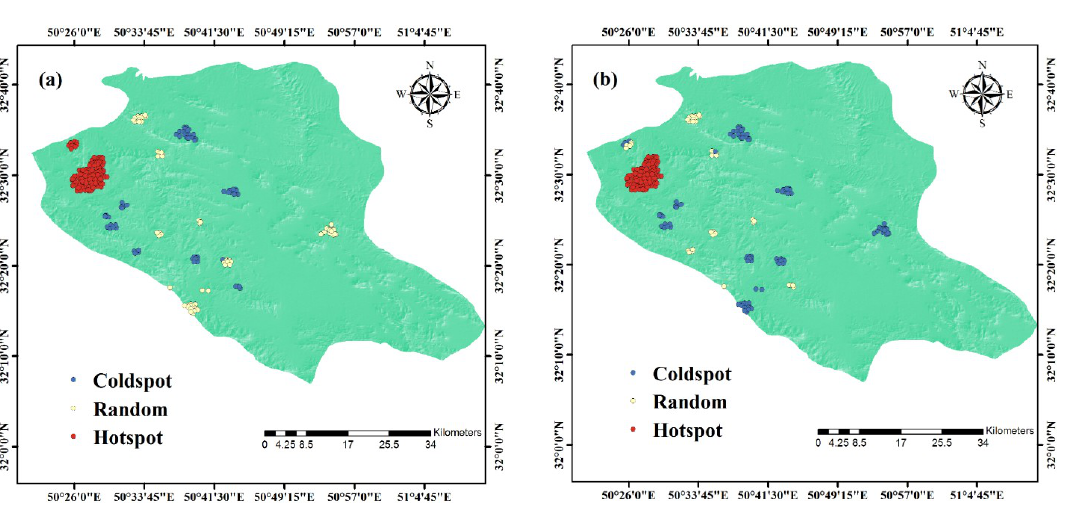
Table 3. Result of Moran’s I index parameters.